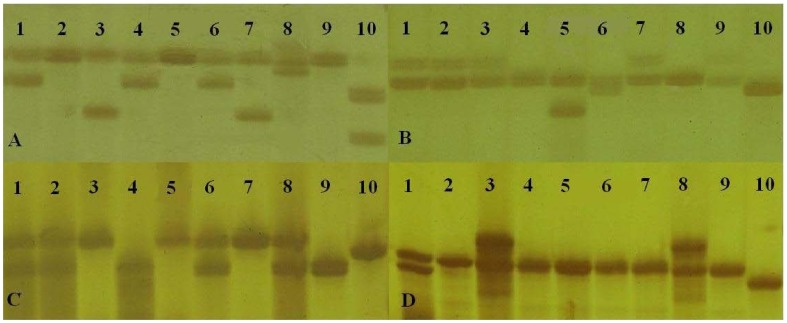
Silver stained polyacrylamide gels of four example SSR loci showed microsatellite polymorphisms in Chinese jujube and related species.The SSR loci BFU2038, BFU2113, BFU2134 and BFU2143 are corresponding to A, B, C and D, respectively. Lane1, ‘Hupingzao’; Lane2, ‘Yuanling’; Lane3, ‘Dongzao’; Lane4, ‘Junzao’; Lane5, ‘Jidanzao’; Lane6, ‘Mayizao’; Lane7, ‘Jinsixiaozao’; Lane8, ‘Huizao’; Lane9, ‘Anonymous’; Lane10, ‘Wanglang’.